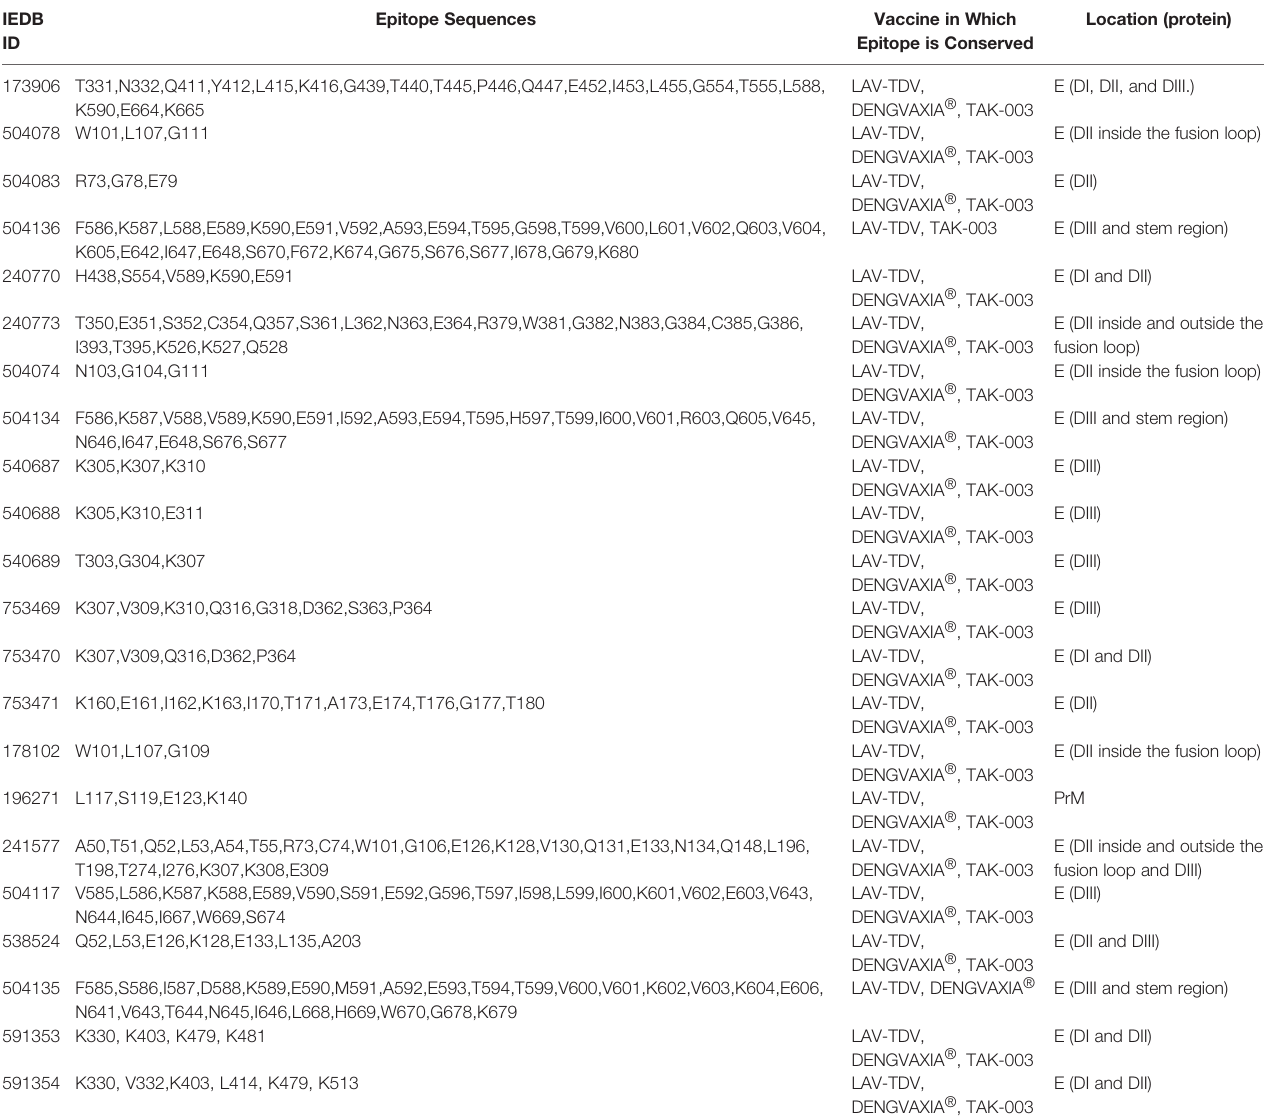
Epitope Sequences Vaccine in Which